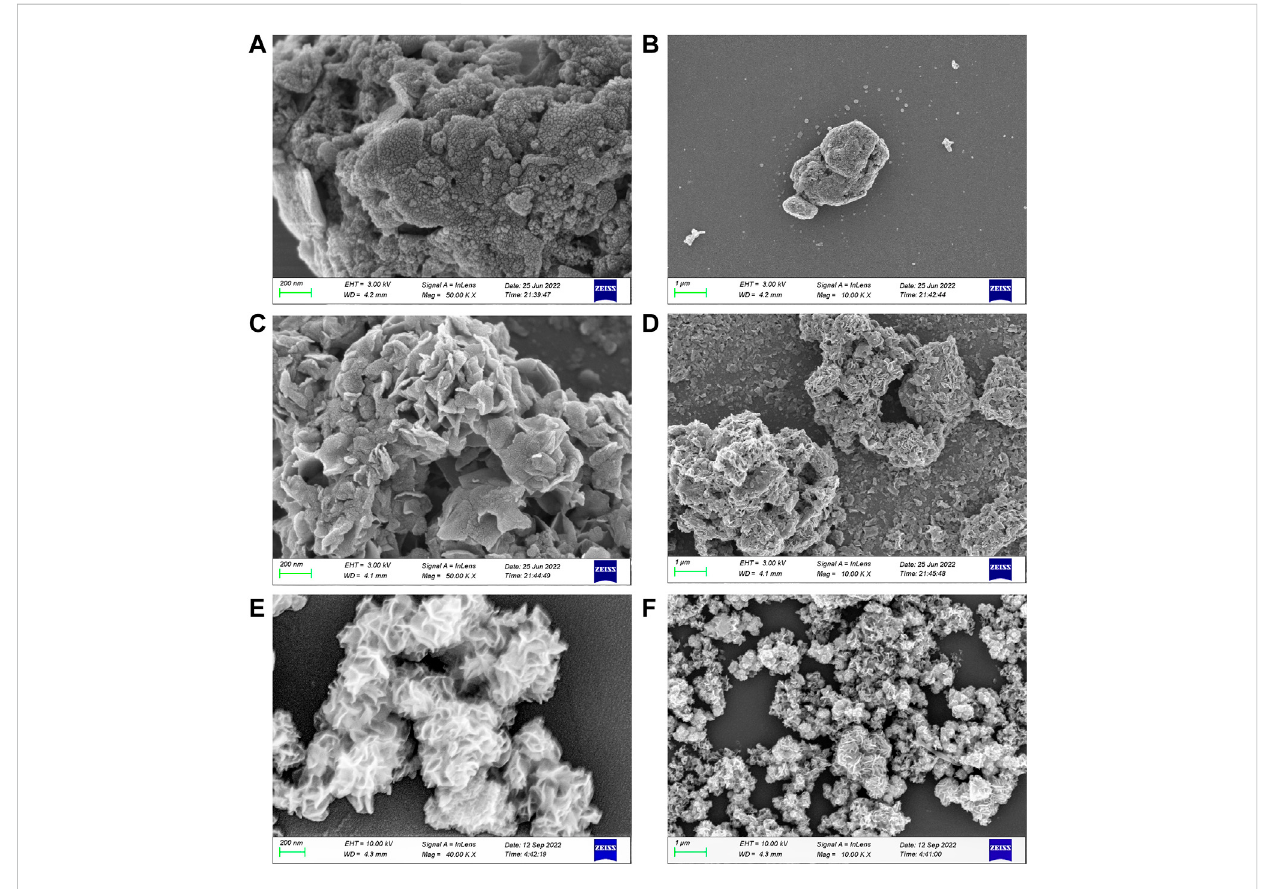
FIGURE 1 (A, B) SEM images of CMB, (C, D) CMB@1T-MoS 2 , (E, F) 1T-MoS 2